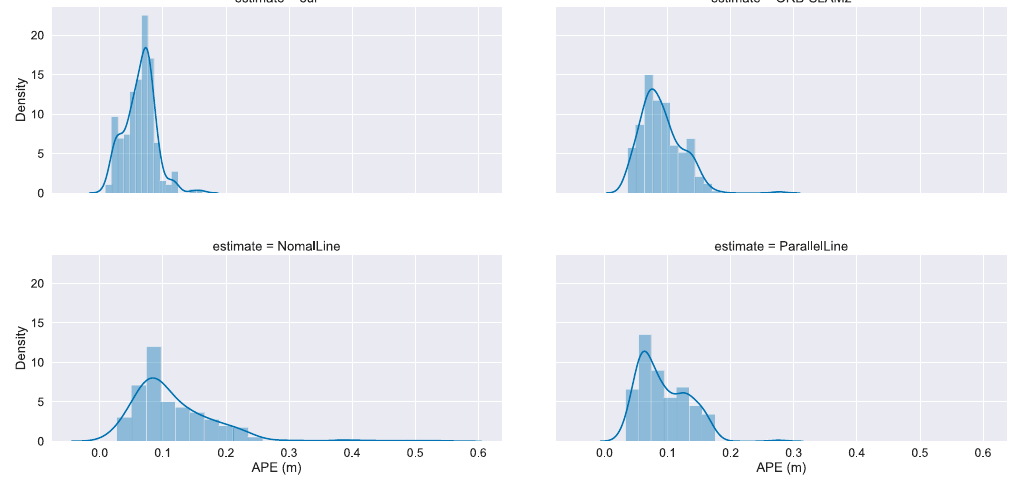
Figure 13. Absolute trajectory error distribution of the four